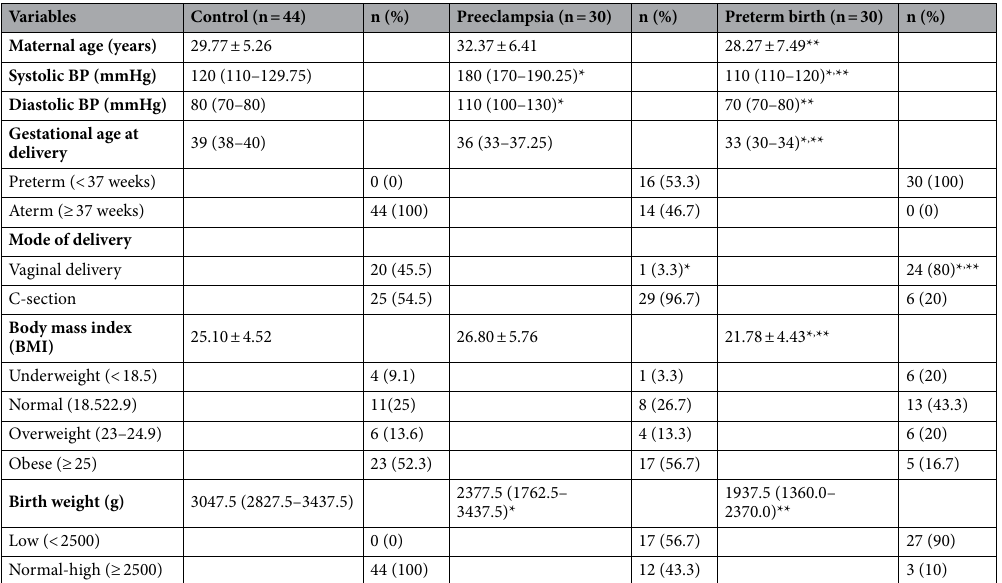
Table 1. Characteristics of subjects (n = 104). Data presented in Mean ± SD or Median (IQR). *Significances to control ( p < 0.05). **Significances to preeclampsia ( p <